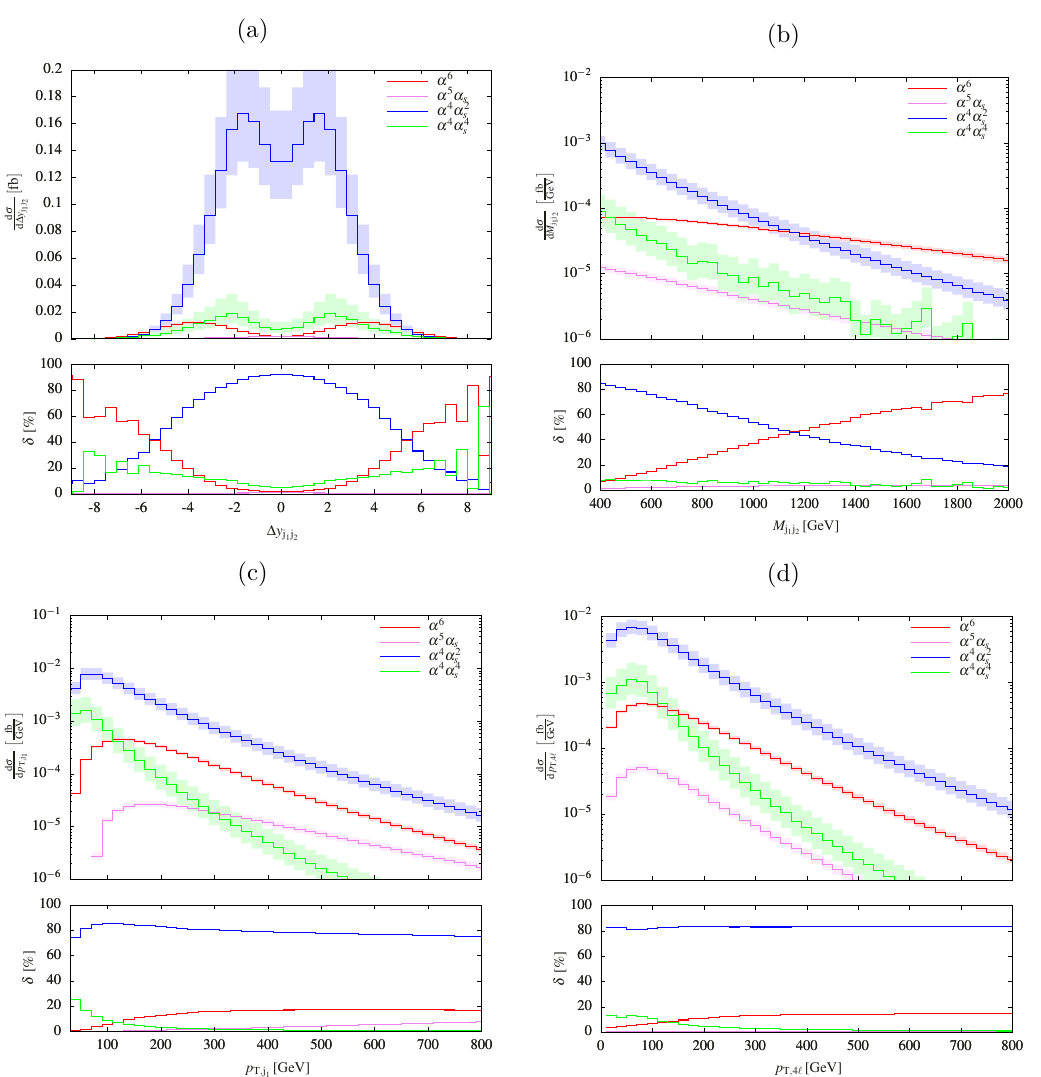
(cid:0) (cid:1) (cid:0) (cid:1) α 6 (EW contribution), O α s α 5 (interference), (cid:0) (cid:1) α 4 α 4 . s